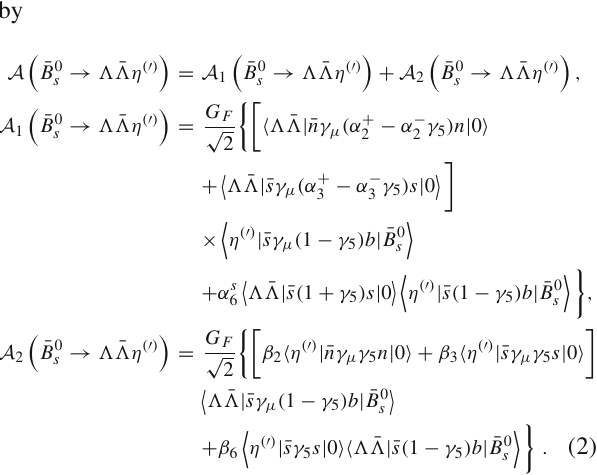
Fig. 1 The short-distance pictures for B → B ¯ B (cid:3) M through the three quasi-two-body decays, where a – c correspond to the collinearly moving M B , M ¯ B (cid:3) and B ¯ B (cid:3) , respectively and q 2 ¯ q 2 are connected by the gluons g 1 , 2 , respectively. Fig. 2. Similarly, the amplitudes of